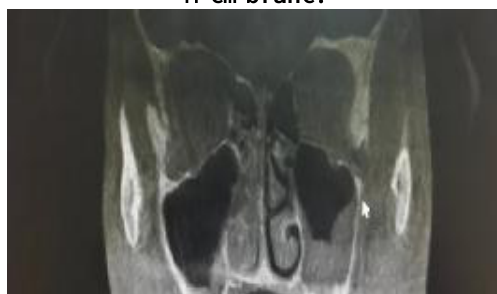
Figure 2: Coronal view Showing Unilateral Thickening of Maxillary Sinus Membrane